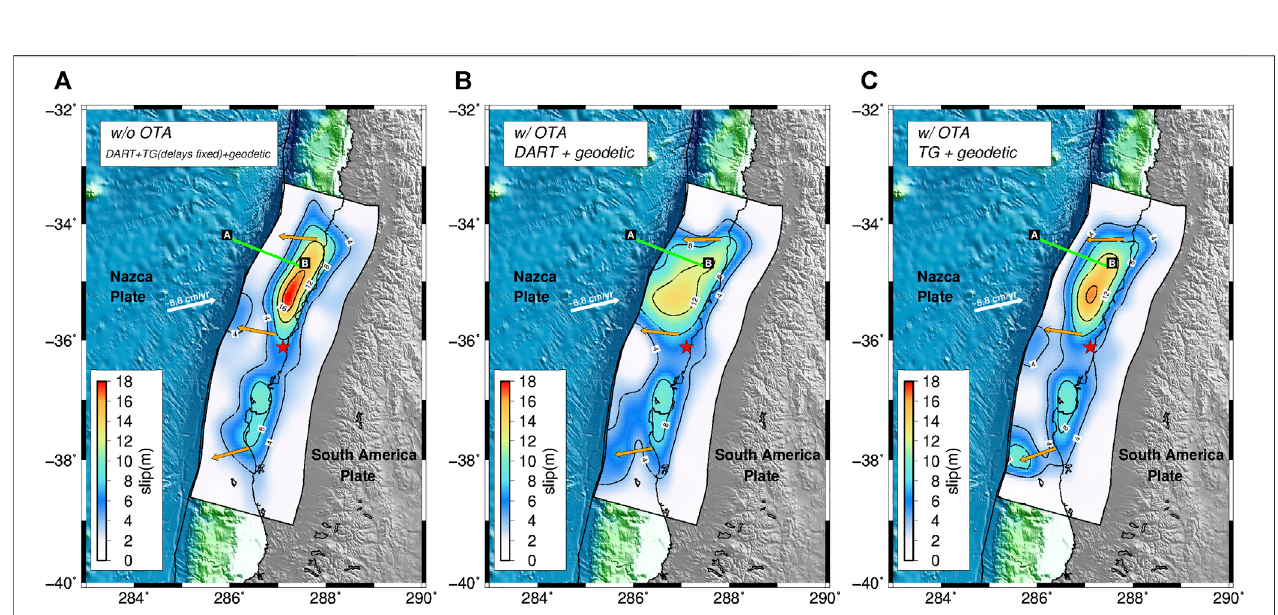
FIGURE 5 | Rupture model of the 2010 Maule earthquake. Slip model (4 m contour lines in black) estimated by repeating the study of Lorito et al. (2011), jointly inverting geodetic, DART, and tide-gauge data without OTA but applying ad hoc rigid time shifts to the tide-gauges waveforms (A) . Slip models estimated by joint inversion of geodetic and DART data (B) , and joint inversion of geodetic and tide-gauge data (C) . Red star represents the epicenter of the Maule earthquake; orange arrows represent the average slip directions (rake); green line represents the ILOCA track. The inversions in (B) and (C) have been performed using OTA.